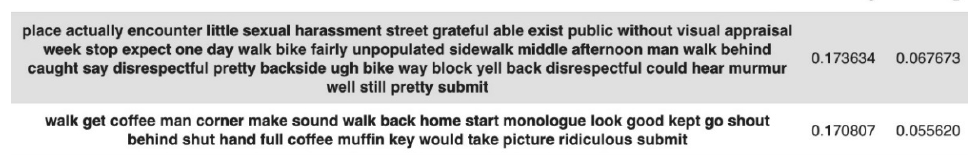
Figure 15. LSA results.